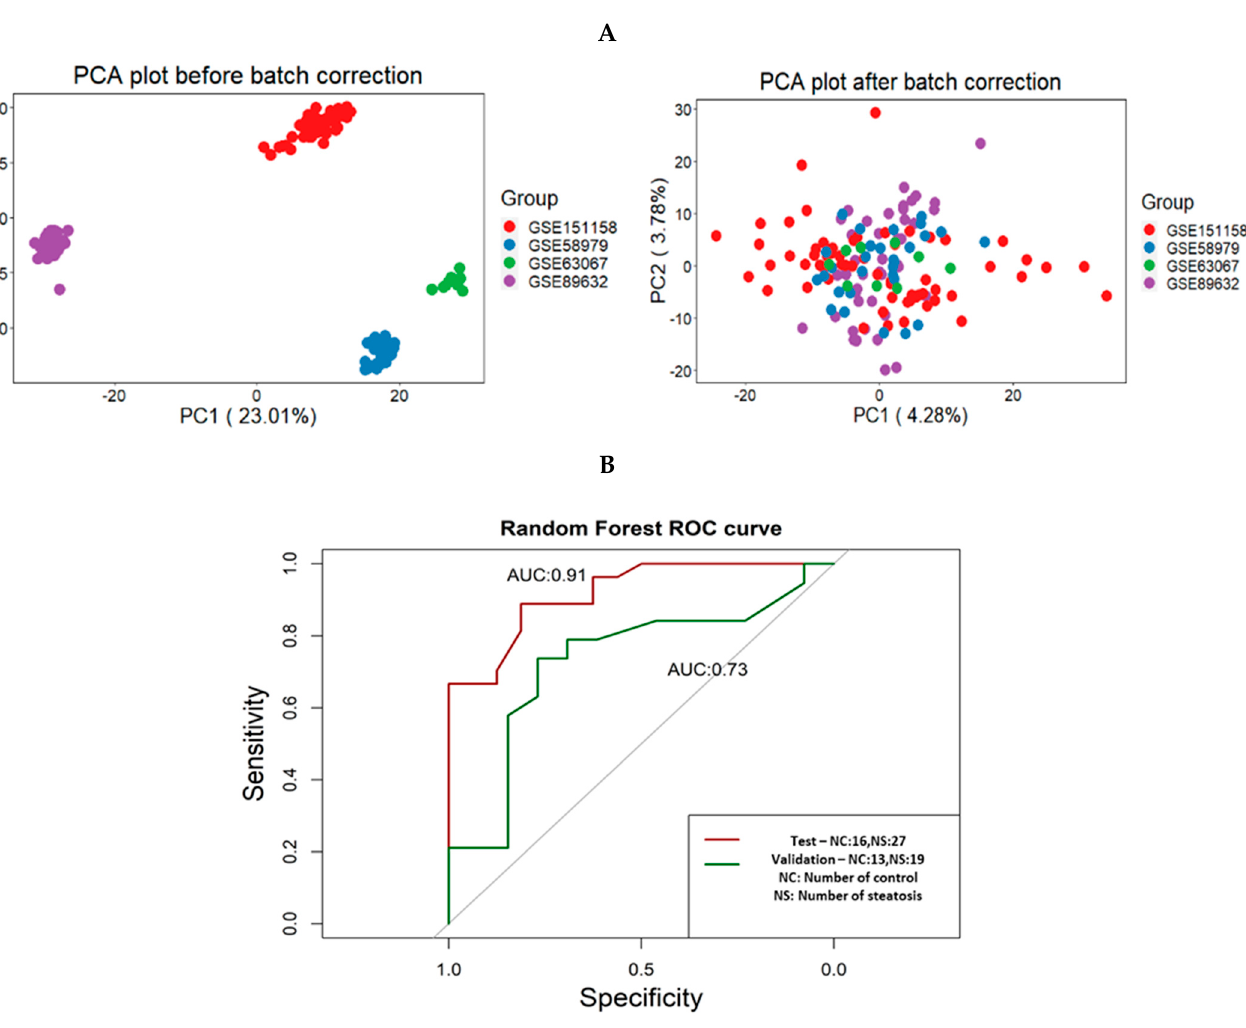
Figure 2. ( A ) A PCA plot that shows how the datasets behaved before and after the batch correction was implemented using ComBat . ( B ) The AUC values of the test and validation sets of the random forest model.